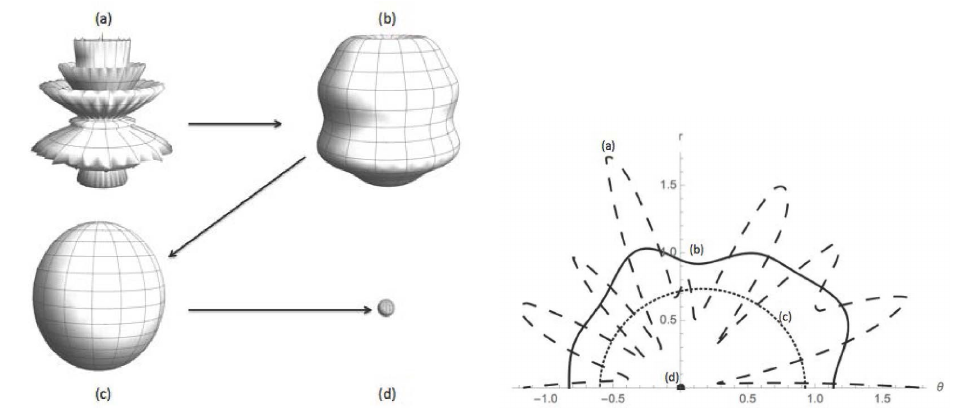
Figure 2. This illustration is of the dimpled sphere and the corresponding radial profiles r ( θ , t ) at time